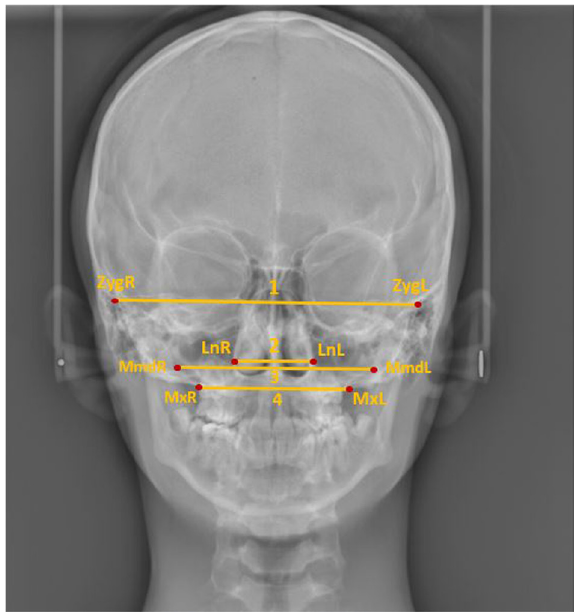
Figure 4. (1) Bizygomatic width, (2) lateronasal width, (3) maxilloman- dibulare width, (4) maxillare